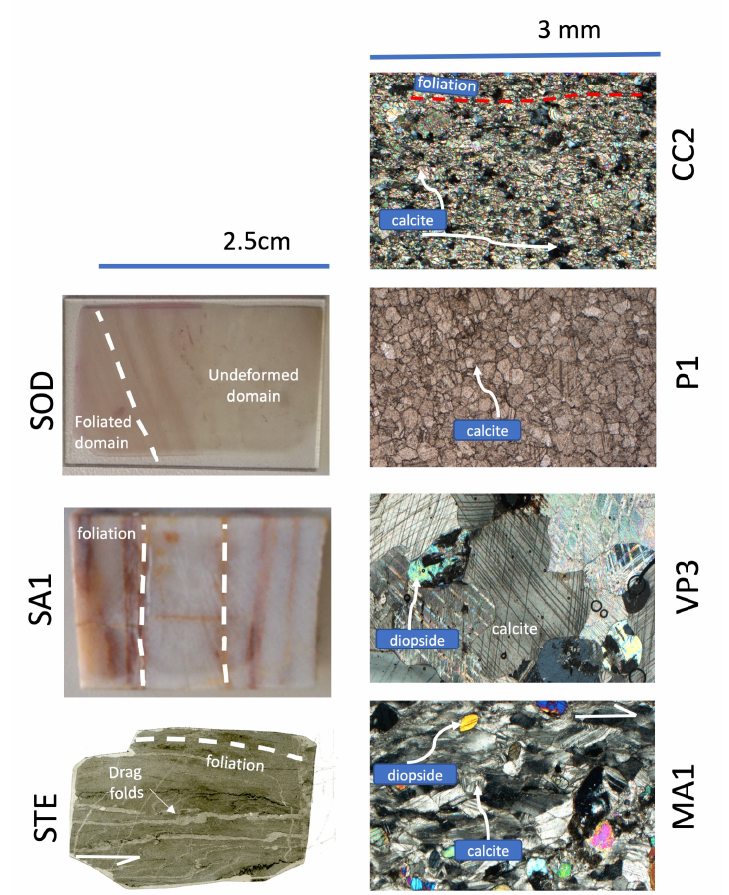
Figure 2. Images of selected samples showing main fabric features as layering or foliation. Scale is indicated. The long side of the image 2.5 cm for STE, SA1, and SOD; long side of the image is 3.0 mm for MA1, VP3, P1, and CC2. MA1, VP3, and CC2 images with crossed polarizers. P1 image with plane